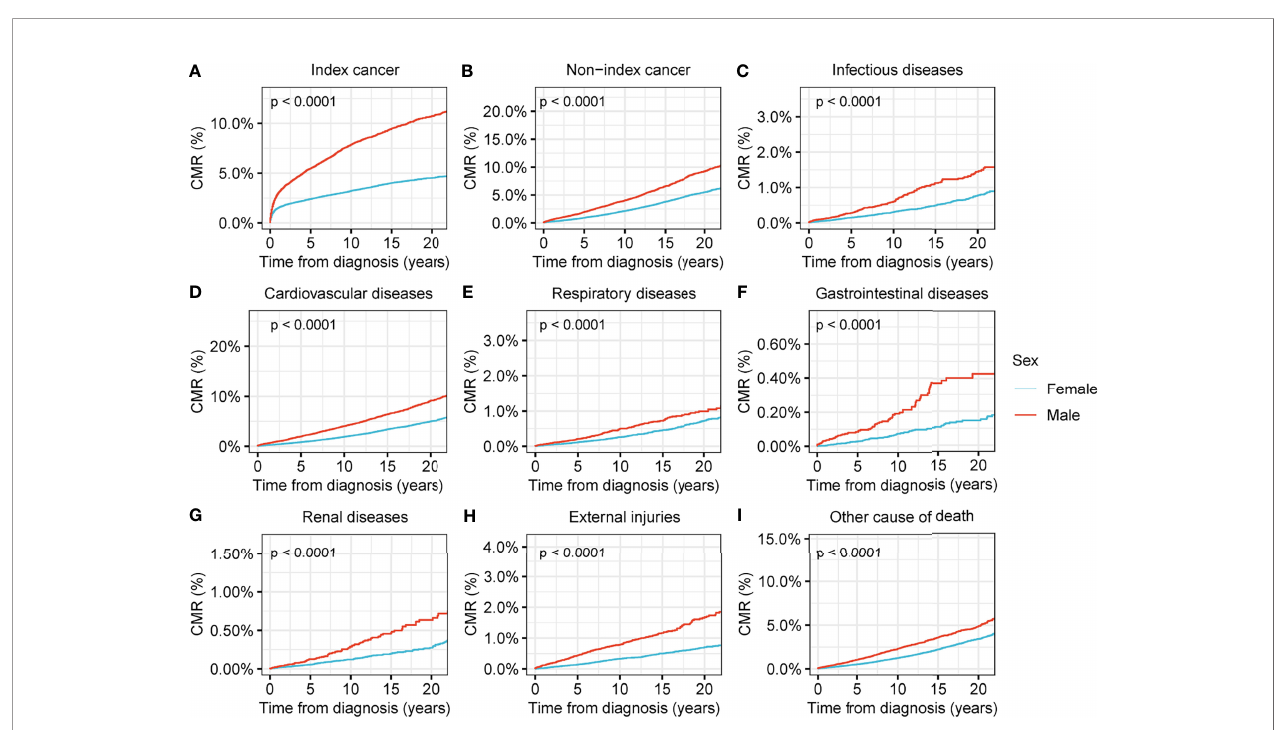
FIGURE 2 | Cumulative mortality rate of deaths from index cancer, non-index cancer and other non-cancer causes among patients with thyroid cancer.